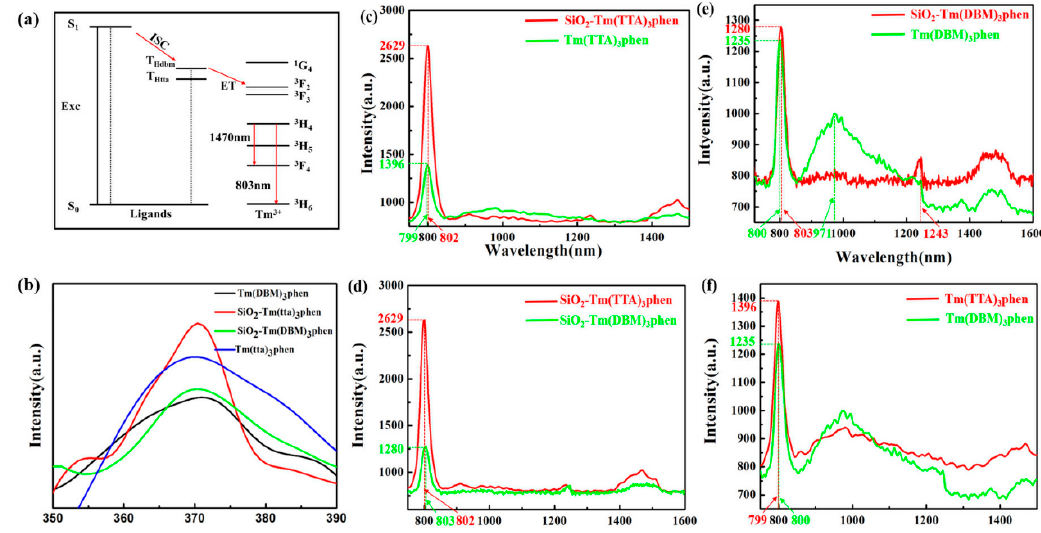
Figure 7. ( a ) Schematic energy diagram for the indirect excitation mechanism of theTm 3+ -ligands system; ( b ) excitation spectra of Tm(DBM) 3 phen, SiO 2 -Tm(TTA) 3 phen, SiO 2 -Tm(DBM) 3 phen, and Tm(TTA) 3 phen ( λ em = 802 nm). Fluorescent spectra of ( c ) Tm(TTA) 3 phen and SiO 2 -Tm(TTA) 3 phen, ( d ) SiO 2 -Tm(DBM) 3 phenand SiO 2 -Tm(TTA) 3 phen, ( e ) Tm(DBM) 3 phen and SiO 2 -Tm(DBM) 3 phen, and ( f )